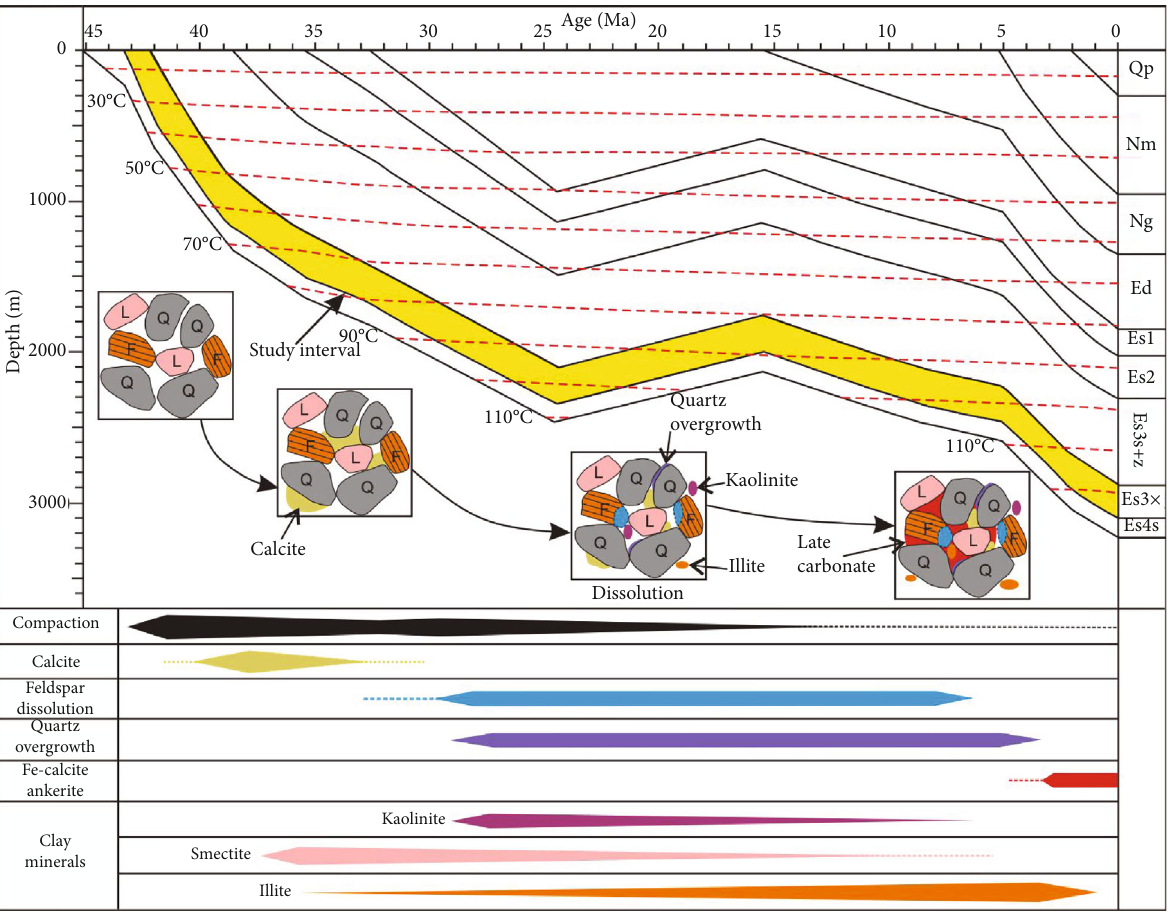
Figure 12: Burial and diagenetic history of the Es3x Formation sandstone reservoirs, modi fi ed from [27,